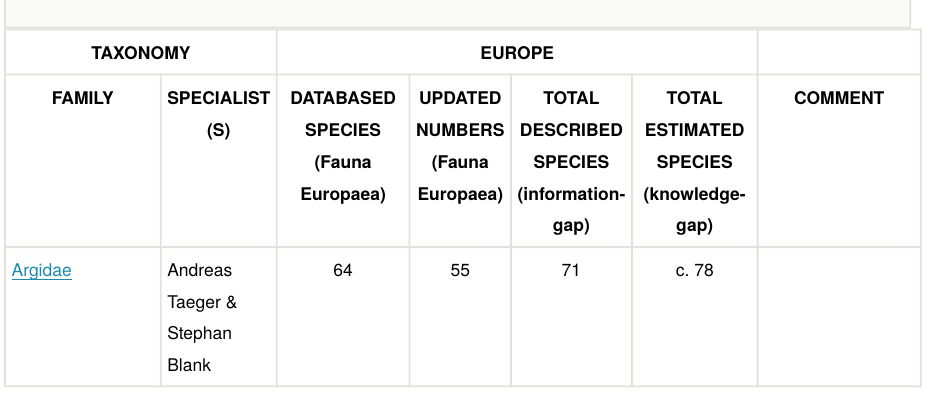
Responsible specialists per family in Hymenoptera — Symphyta +